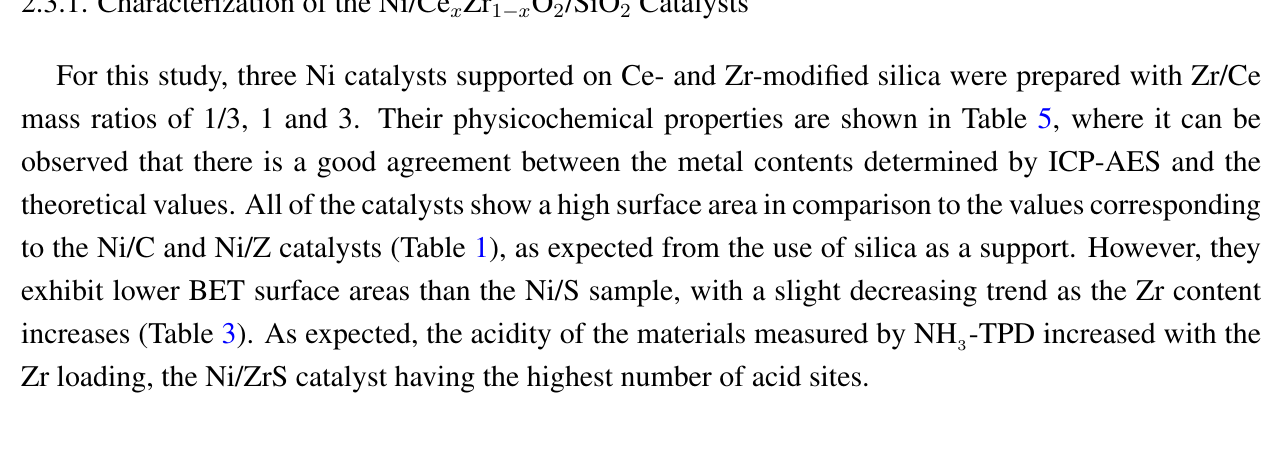
Table 5. Physicochemical properties of the Ni/Ce